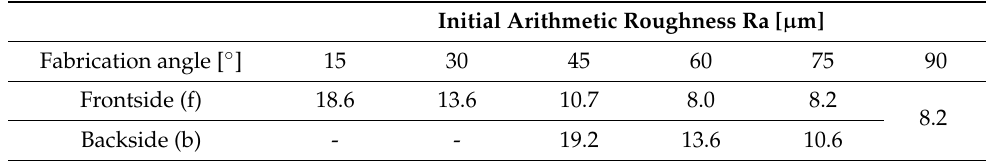
Table 2. Initial arithmetic surface roughness Ra of the samples depending on the fabrication angle and side after additive manufacturing, measured in